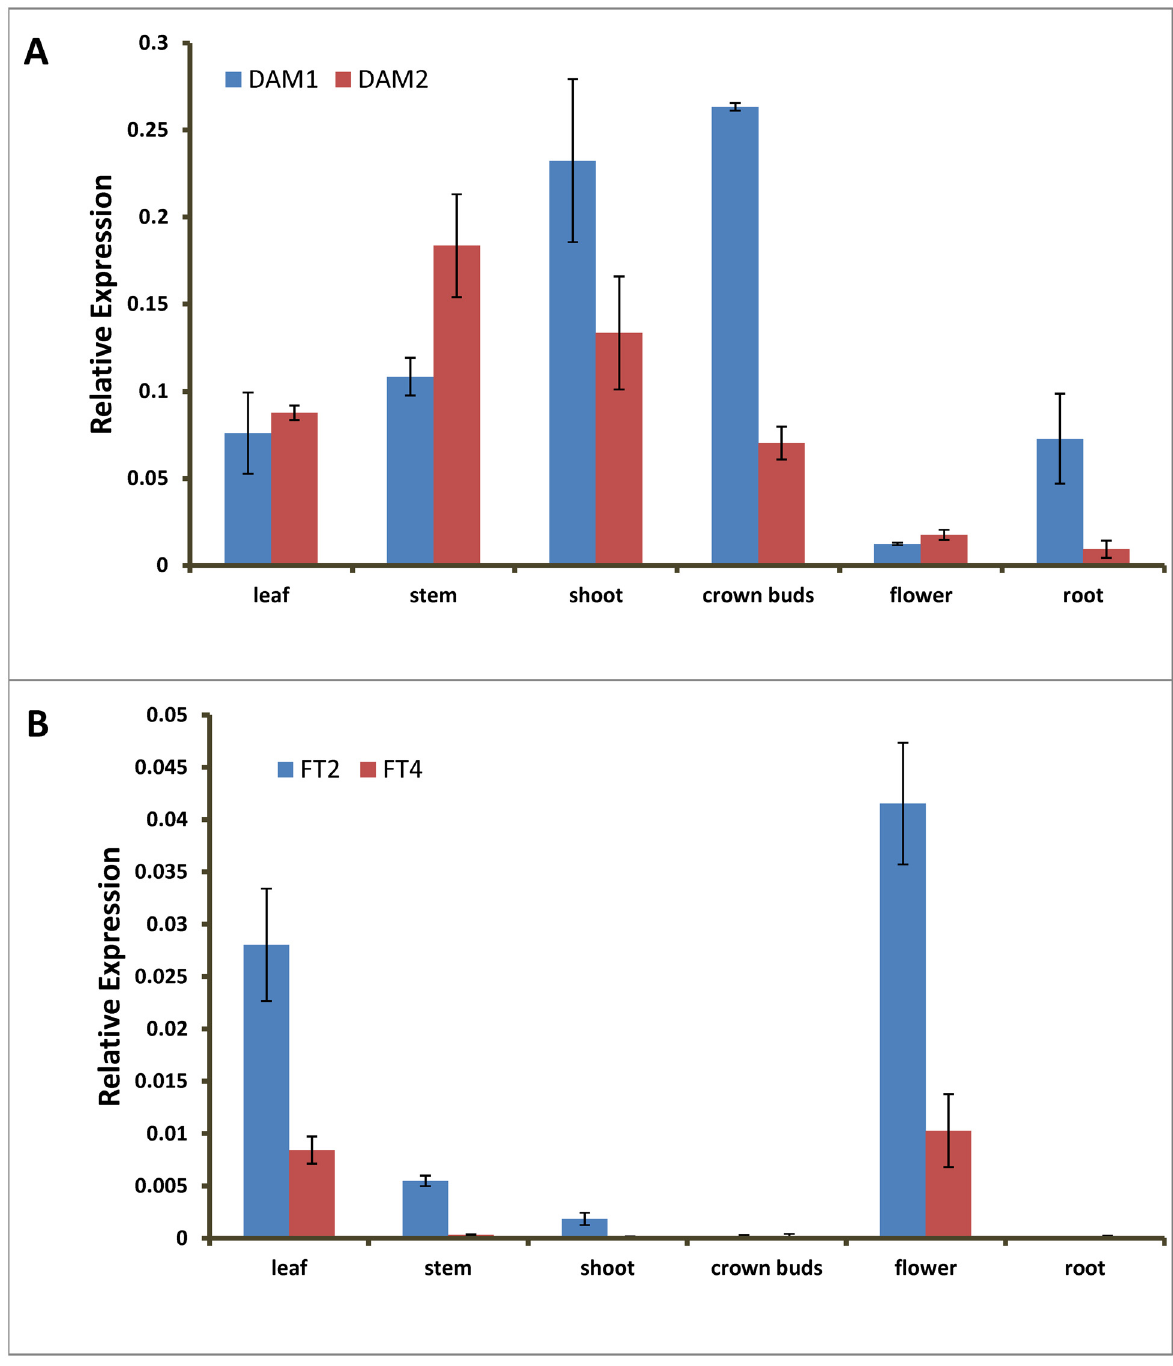
Fig 2. Tissue specific expression of leafy spurge DAM and FT genes. Gene expression in leaf, stem, shoot, crown buds, flower and root were examined at the end of a 16 hr photoperiod under non-dormancy inducing conditions. (A) DAM1 and DAM2 expression in different organs. (B) FT2 and FT4 expression in different organs. Error bars show standard deviation from three biological